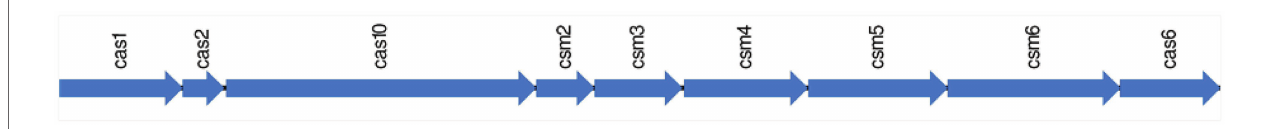
( Figure 2 ) that stand out among the conservative nucleotides: four consecutive nucleotides of cysteine (-CCCC-) and four consecutive nucleotides of guanine (-GGGG-). Among the conserved motifs, there is a constant region of eight nucleotides.